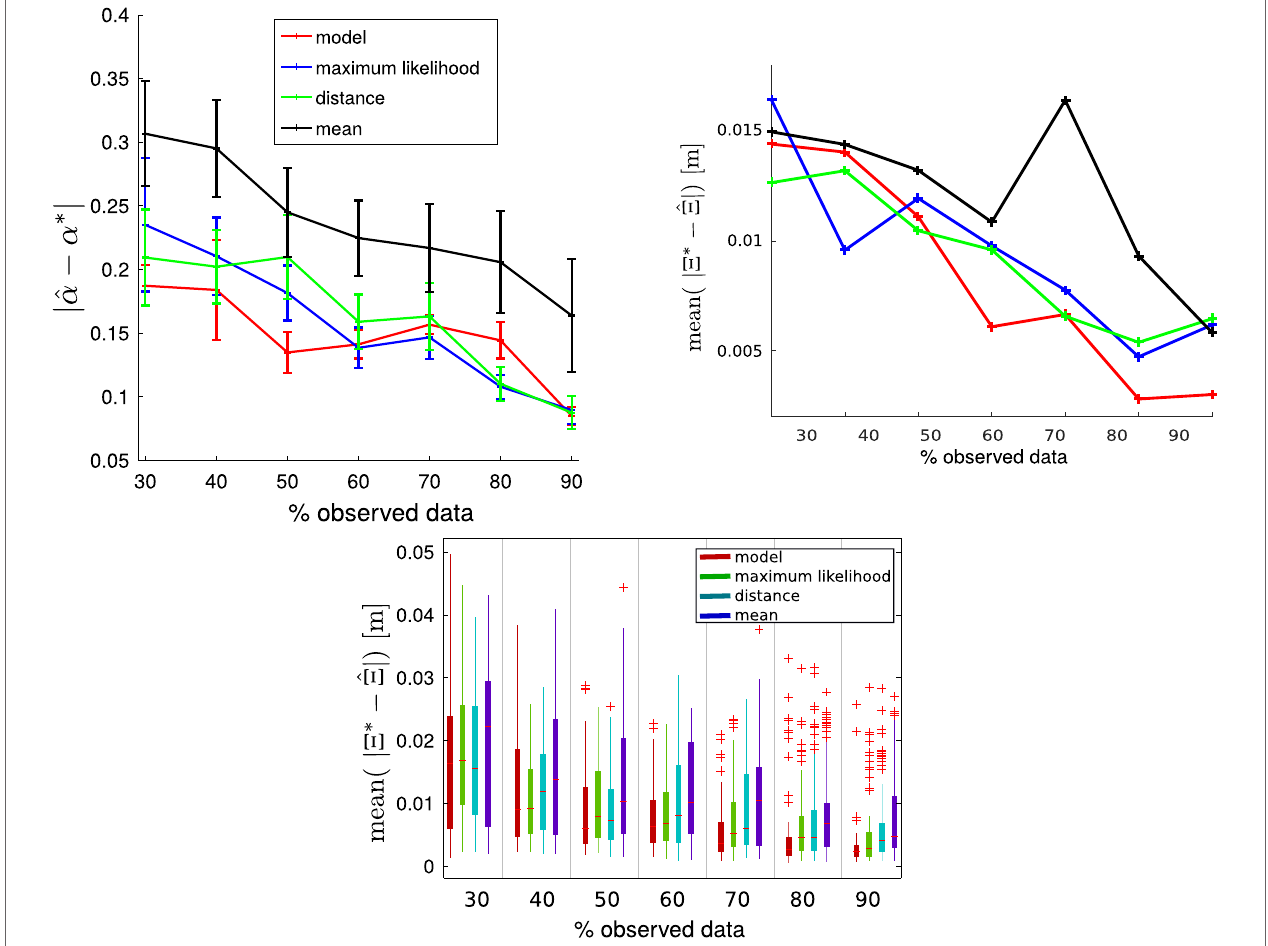
FIGURE 9 | (Top left) Error of (cid:11) estimation; (top right and bottom) error of trajectory prediction according to the number of known data and the method used. We executed 10 different trials for each case.